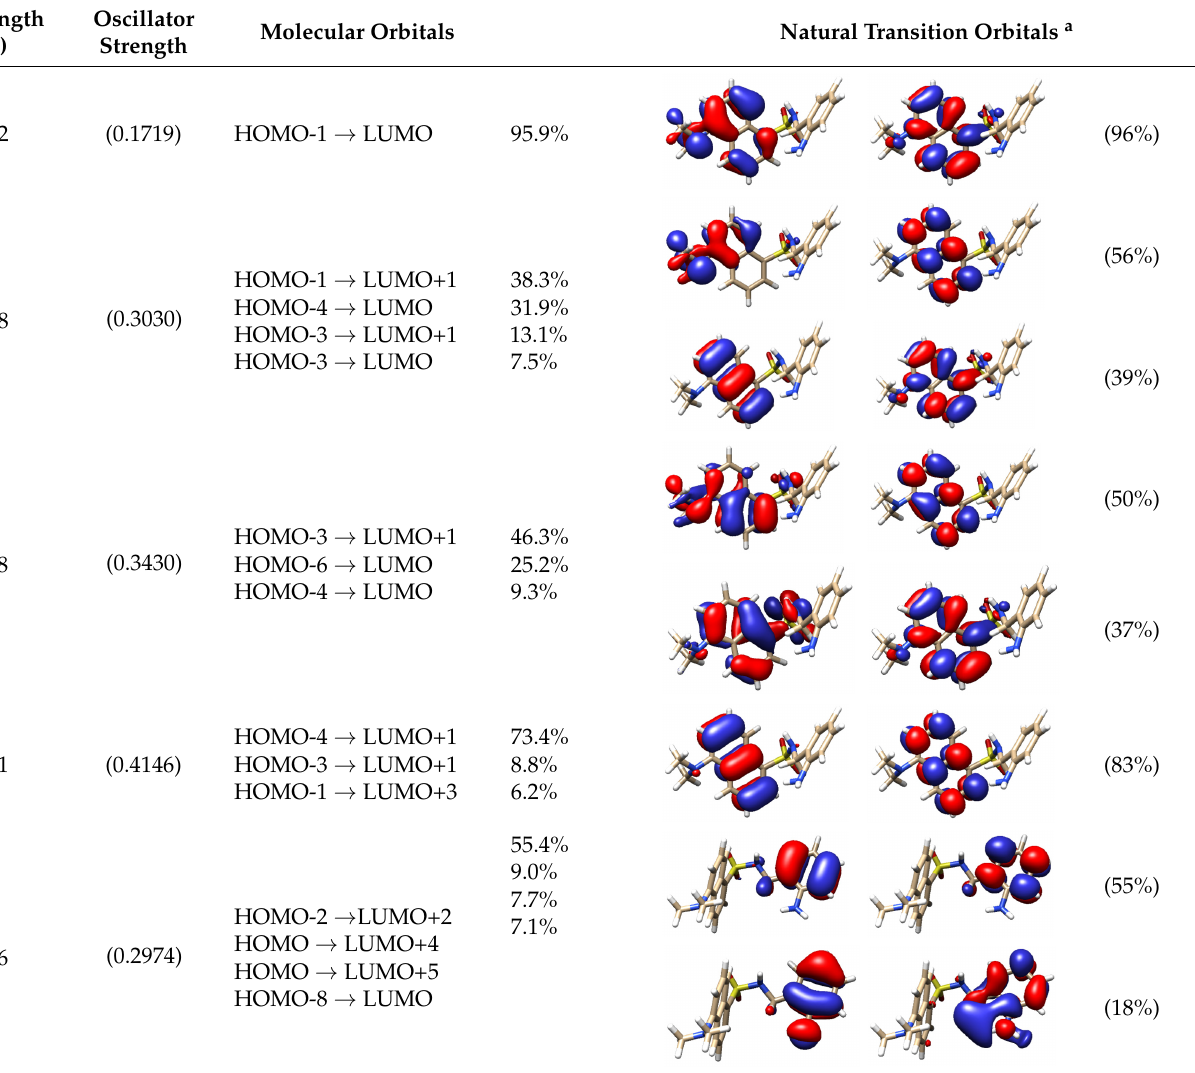
Table 1. Molecular orbitals involved in the main transitions originating the UV-Vis spectrum of DsA.